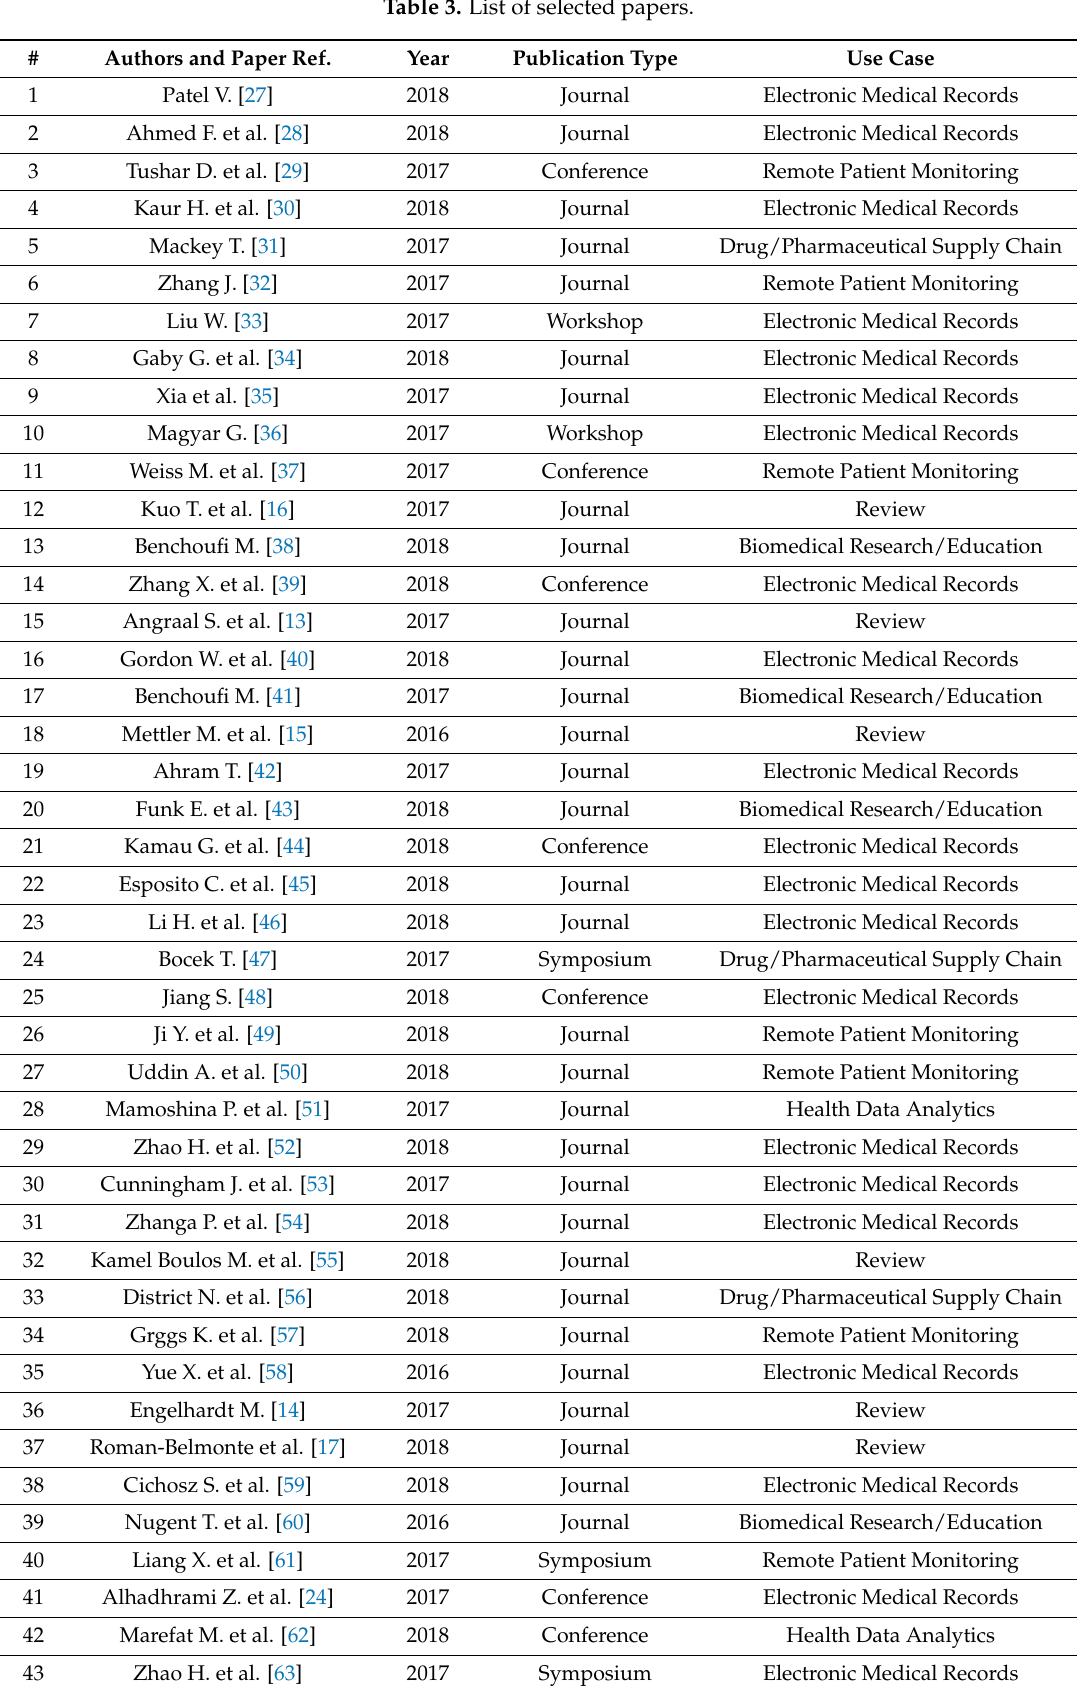
Table 3. List of selected